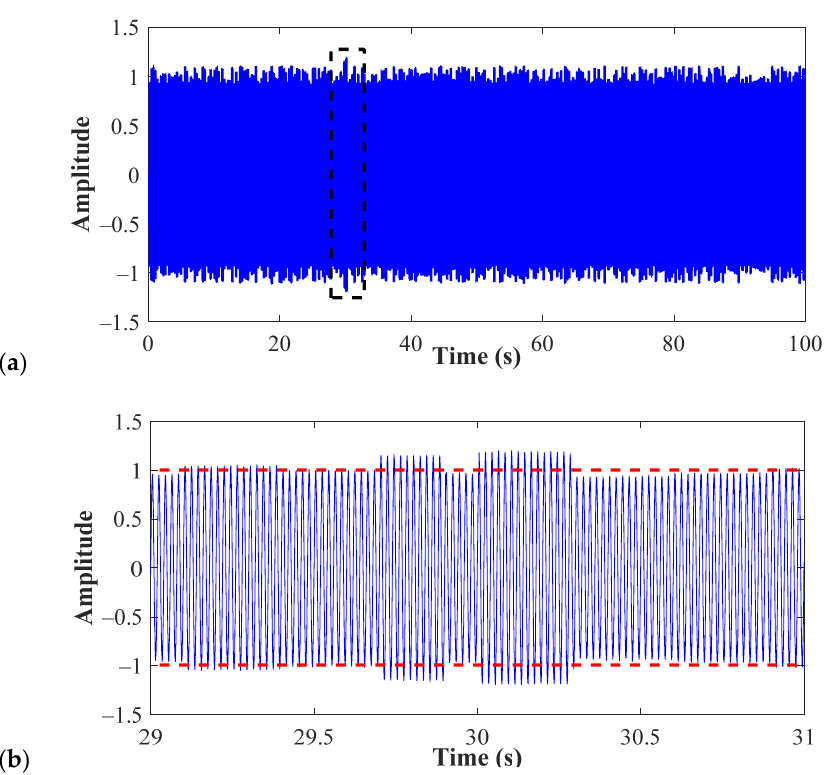
Figure 9. Real signal analyzed through the proposed PQ detection strategy: ( a ) representation of 100 s of the analyzed signal and ( b ) zoom over the near area where the detection of swell is presented.